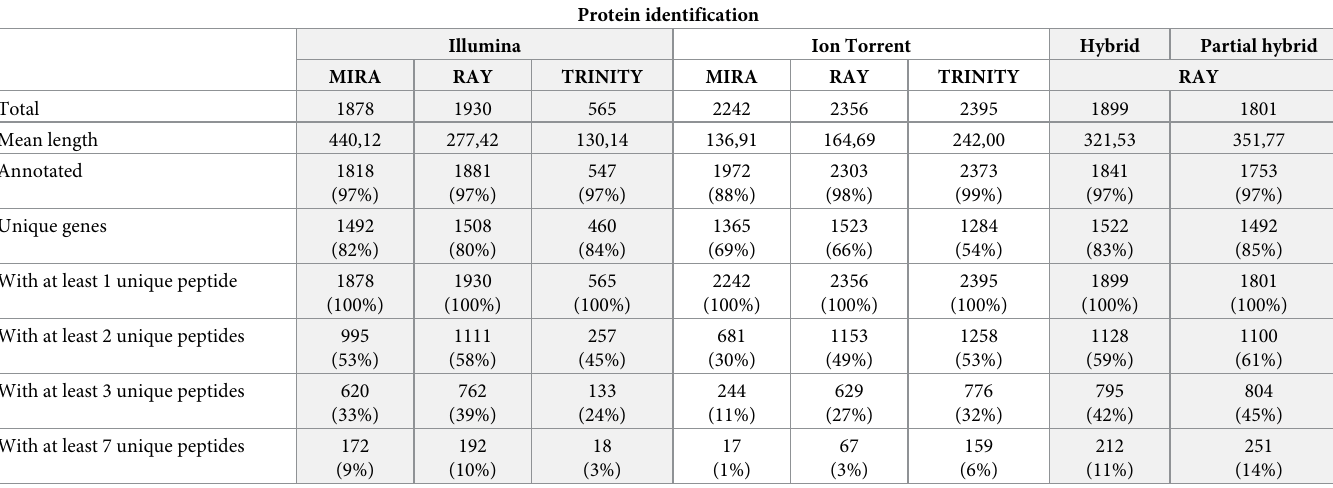
Table 3. Summary of the total number of proteins annotated in holm